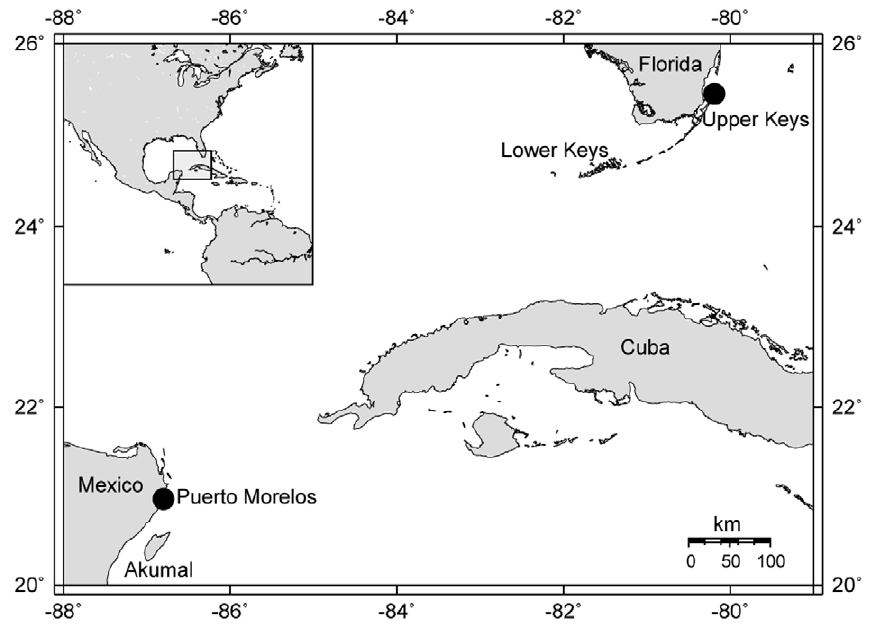
Figure 1. Map of the western Atlantic and northern Caribbean with study locations indicated by black circles. doi:10.1371/journal.pone.0011221.g001 2005 to 2008, calculated by averaging monthly means of hourly data, are 26.4 u C and 29.3 u C in Florida and 28.3 u C and 29.5 u C in Mexico. Control temperatures were near the annual mean for both locations (27 u C Florida and 27.5 u C Mexico; ‘‘mean’’). High treatment temperatures were 1 to 2 u C above the summer means (30 u C Florida and 31.5 u C Mexico; ‘‘high’’) (Fig. 2).